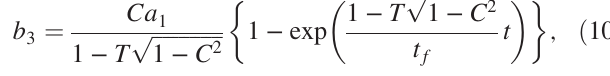
ffiffiffiffiffiffiffiffiffiffiffiffiffiffiffiffiffiffiffiffiffiffiffiffiffi p 2 π h 2 þ h 2 þ l 2